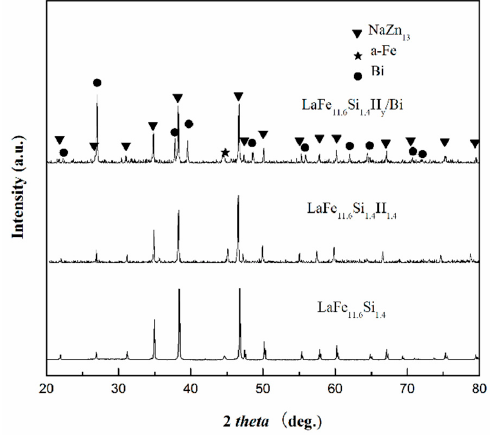
Figure 1. Powder XRD patterns for LaFe 11.6 Si 1.4 , LaFe 11.6 Si 1.4 H 1.4 alloy and LaFe 11.6 Si 1.4 H y /Bi samples.